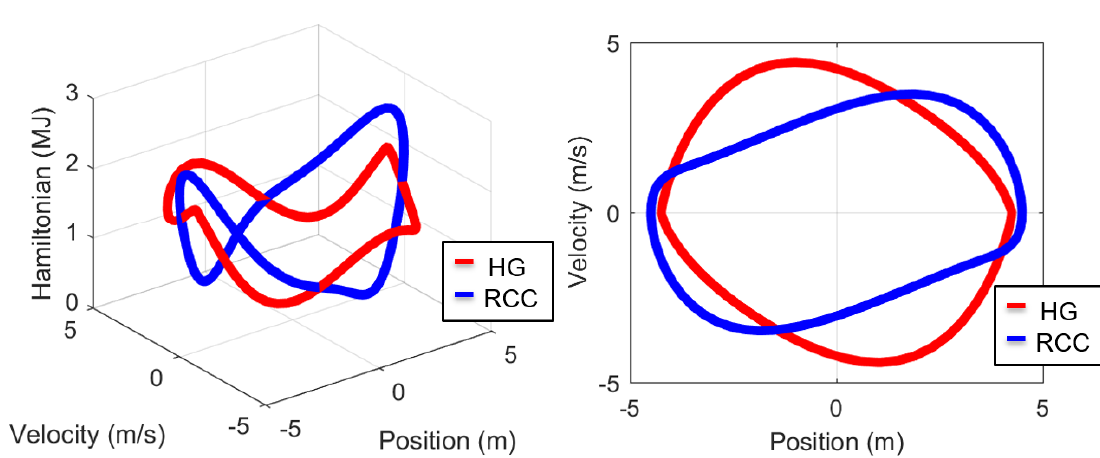
Figure 9. NL limit cycle comparisons, 3d ( left ) and phase-plane ( right ),